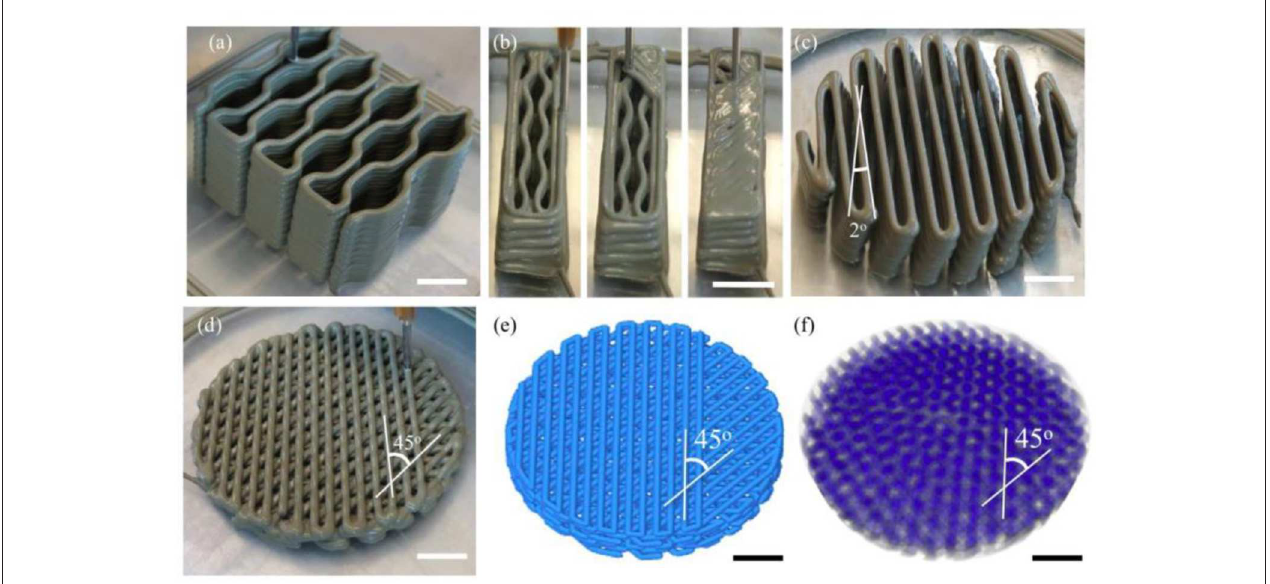
FIGURE 4 | 3D printed cementitious structures with complex geometries. (Scale bar − 10mm) Figure adapted from Moini et al. (2018), with permission from John Wiley and Sons. (a–f) Different printed morphologies along with respective schematics.